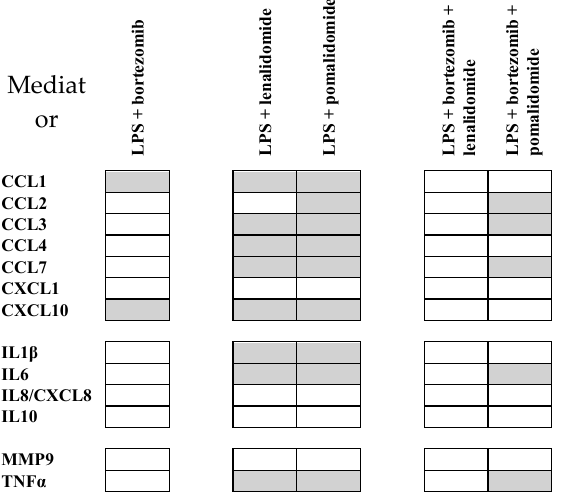
Figure 6. The effects of TLR4/LPS, bortezomib, and IMiDs on the release of soluble mediators by normal monocytes; a summary of the overall results for five healthy blood donors. We compared the mediator levels for (i) cultures prepared in medium with and without LPS 1 ng/mL; and (ii) DMSO containing control cultures with LPS alone versus cultures with LPS together with either lenalidomide 500 ng/mL or pomalidomide 100 ng/mL (i.e., concentrations corresponding to the serum levels reached during myeloma treatment); and (iii) cultures with LPS + bortezomib versus cultures with LPS and bortezomib together with either lenalidomide or pomalidomide. The comparisons showing a similar decrease (i.e., at least 25% reduction) in the soluble mediator level for all five individuals included in the comparisons are indicated in grey; a decrease for all five individuals corresponds to an uncorrected p -value of 0.031 when using the Wilcoxon test for paired samples.